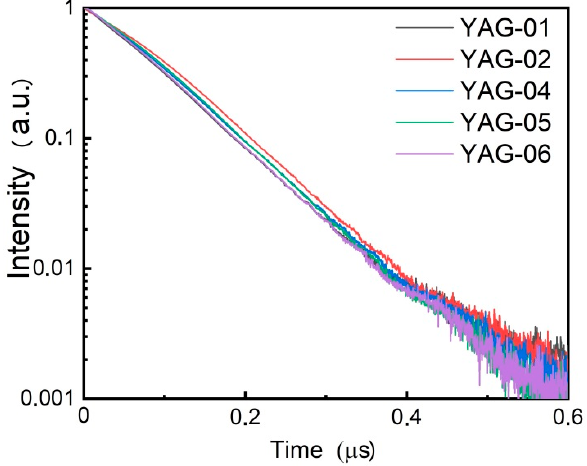
Figure 3. Kinetics of photoluminescence (PL) decay in the region of 530 − 560 nm in C-YAG phosphors.